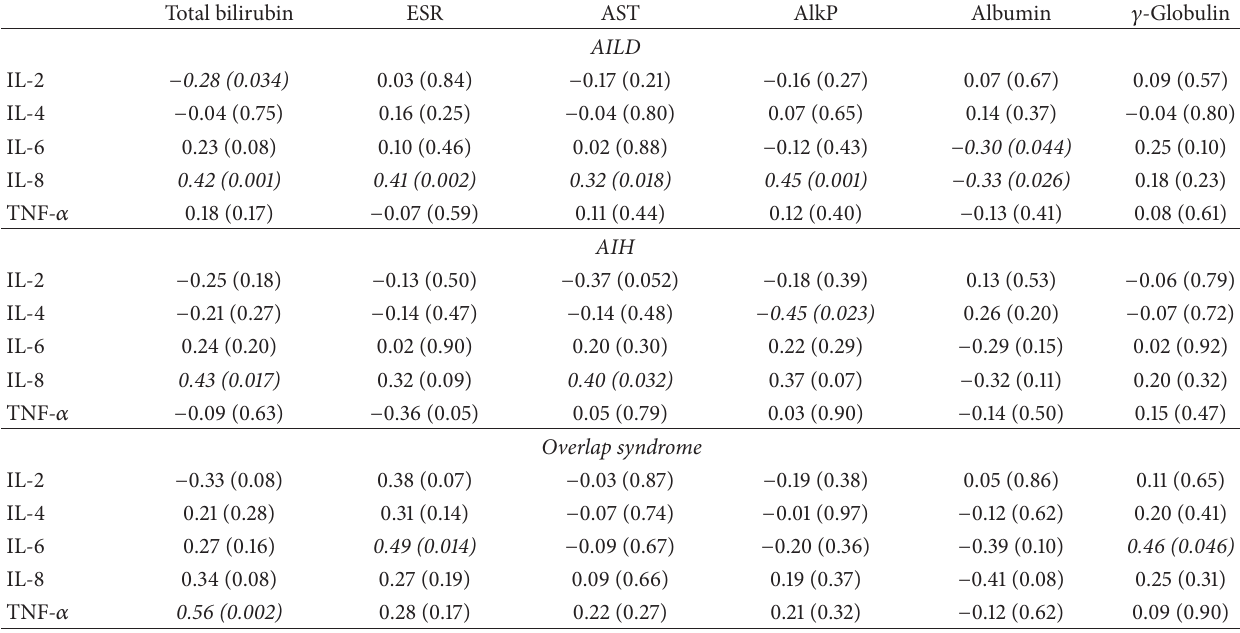
Table 4: Spearman rank correlations between laboratory variables and serum cytokine levels measured. Numbers given are 𝑟(𝑝) values. Statistically significant correlations are marked with italic